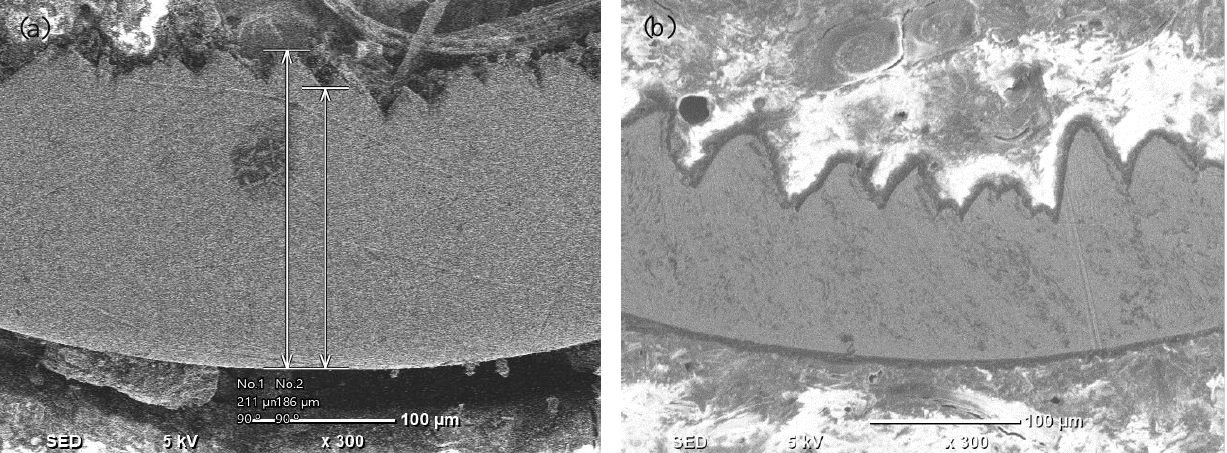
Figure 11. Chip morphology for the two orientations: ( a ) AL orientation and ( b ) PL orientation at f = 0.1 mm/rev, V = 60 m/min, and d = 0.2 mm.